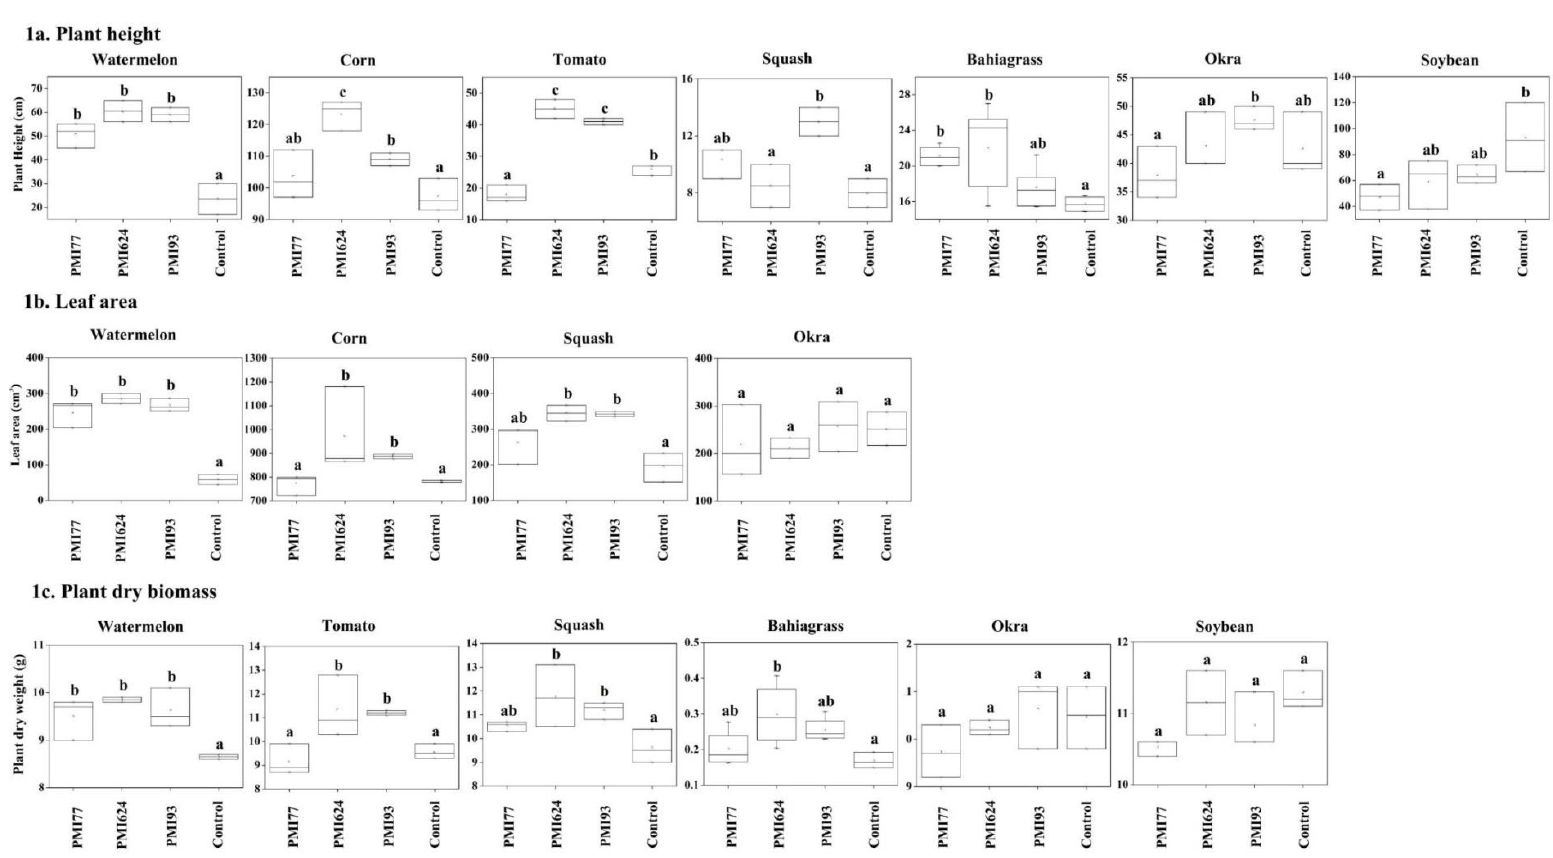
Figure 1. The impacts of Mortierella isolates on the growth of different plants shown by plant height ( 1a ), leaf area ( 1b ), and plant dry weight ( 1c ). Vertical bars represent the standard errors of three replicates. Different lower-case letters represent significant differences across different isolates at P < 0.05.